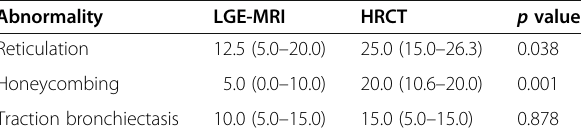
Table 3 Comparison of extent of pulmonary abnormalities on LGE-MRI and HRCT in CPFE